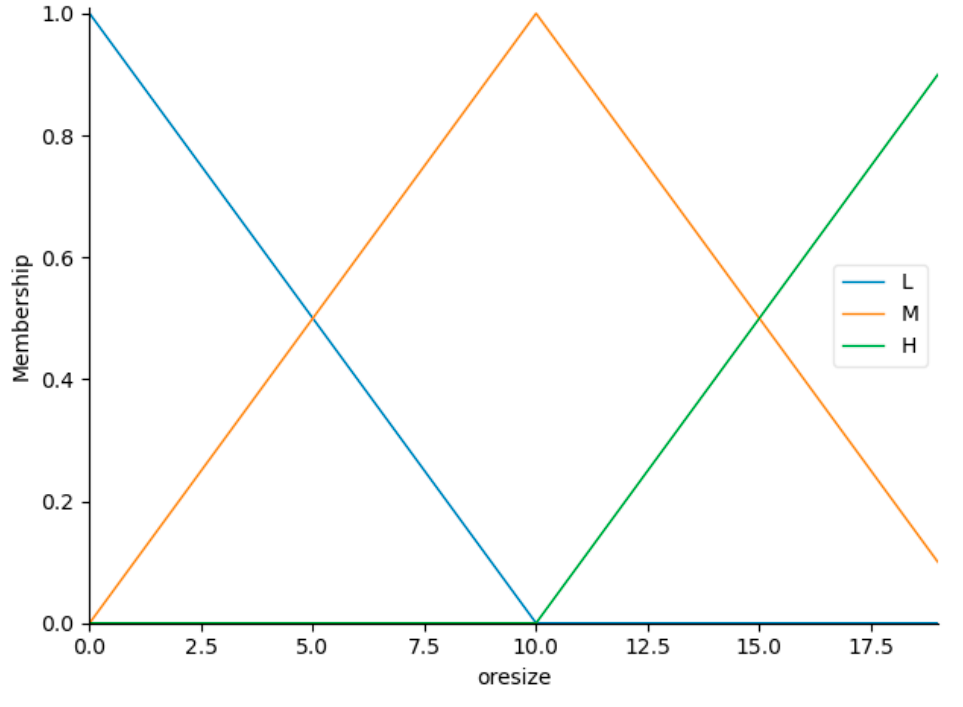
Figure 9. Membership function of ore particle size.